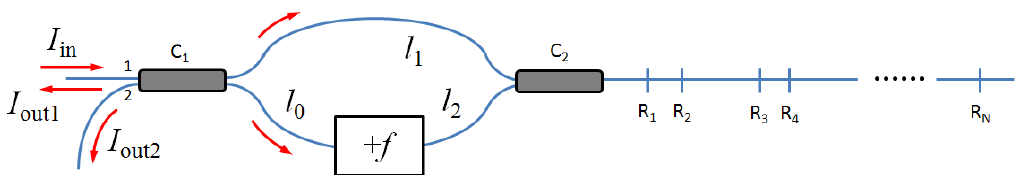
Figure 3. A linear frequency-shifted Sagnac interferometer with multiple reflectors. C C : 50/50 fiber directional couplers, R 2